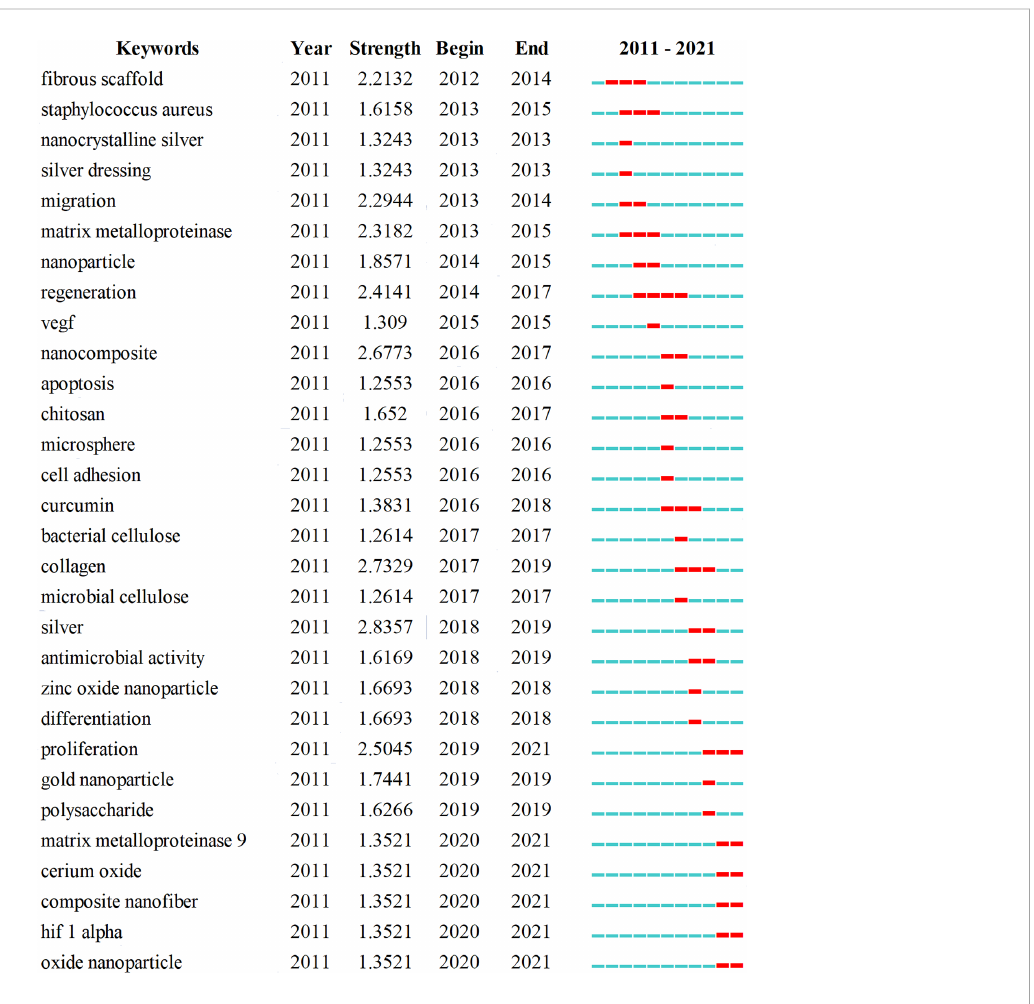
FIGURE 9 Top 30 keywords with the strongest citation